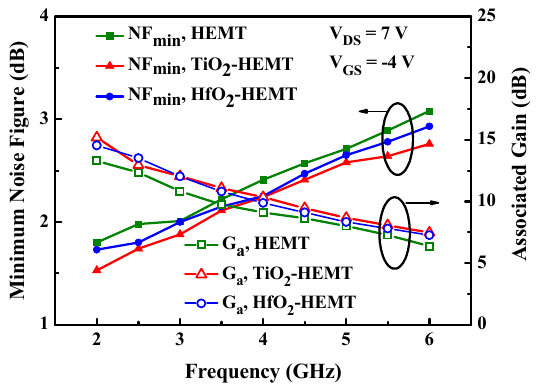
Figure 7. Minimum noise figure and associated gain of the studied ( a ) HEMT, ( b ) HfO 2 -HEMT, and TiO 2 -HEMT.